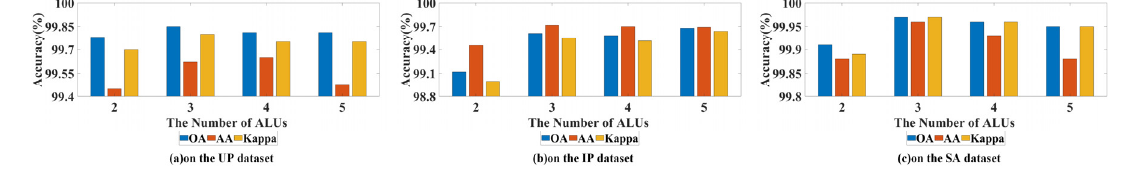
Figure 10. The effect of ALU numbers.